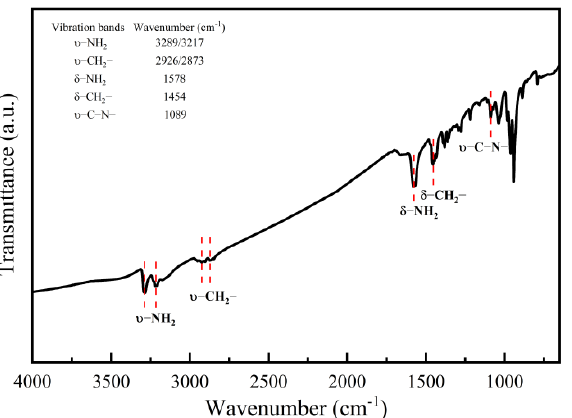
Figure 2. FTIR spectrum of the (Fe 2 Se 3 ) 2 [Fe(dien) 2 ] 0.9 hybrid rods. The inset shows the vibration bands of – CH 2 – , – NH 2 , and – CN – . TGA and dWeight/d T curves in Figure 3 show a weight loss (~6.7 wt%) from room temperature to the onset decomposition temperature ( T onset ) ~540 K due to a small